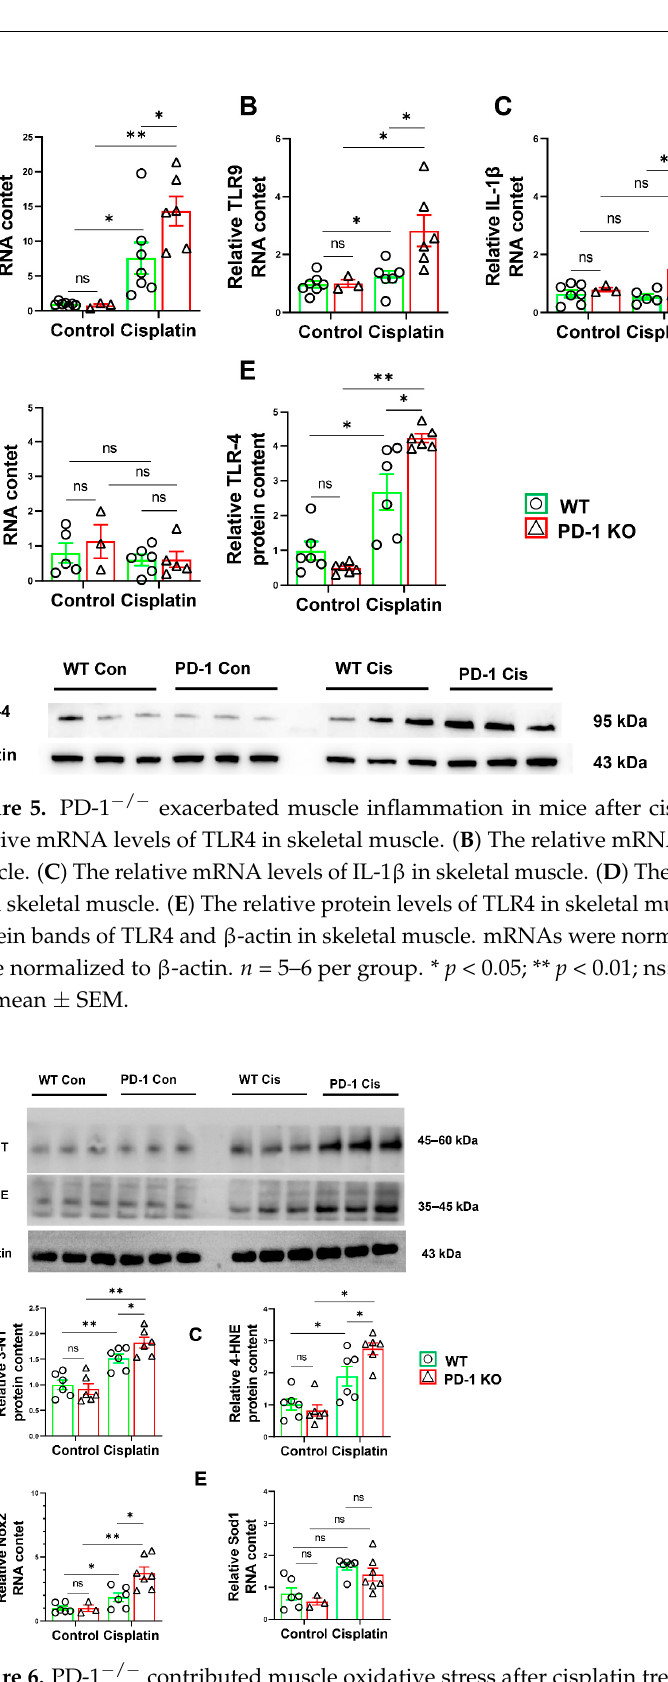
Figure 6. PD-1 − / − contributed muscle oxidative stress after cisplatin treatment. ( A ) The representative protein bands of 3-NT, 4-HNE and β -actin in skeletal muscle. ( B ) The relative protein levels of 3-NT in skeletal muscle. ( C ) The relative protein levels of 4-HNE in skeletal muscle. n = 6 per group. ( D ) The relative mRNA levels of Nox-2 in skeletal muscle. ( E ) The relative mRNA levels of Sod1 in skeletal muscle. * p < 0.05; ** p < 0.01; ns: non-significant. all values are mean ± SEM.